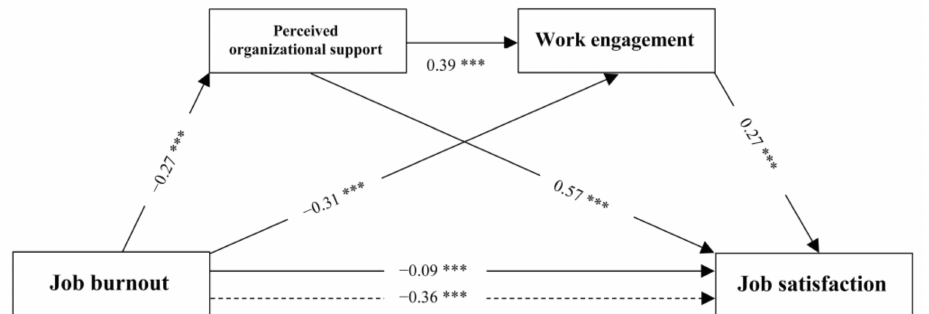
Figure 2. Mediation test. *** p <